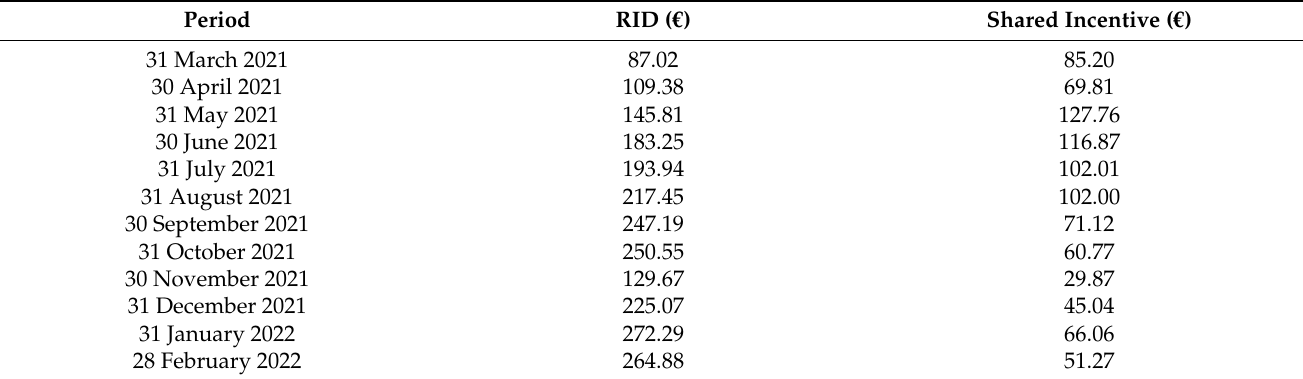
Table 7. Economic quantities for each month under